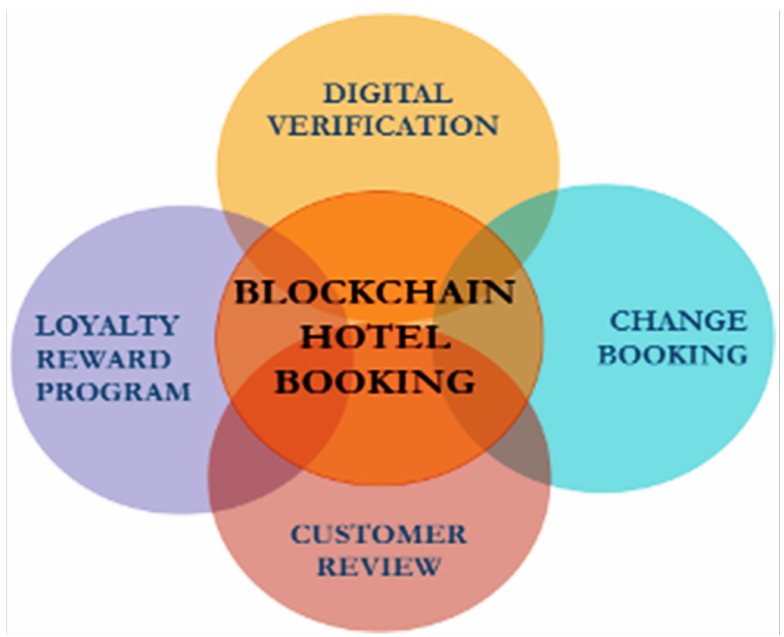
Figure 12. Role of the blockchain in the hotel booking ecosystem. Source: Authors’